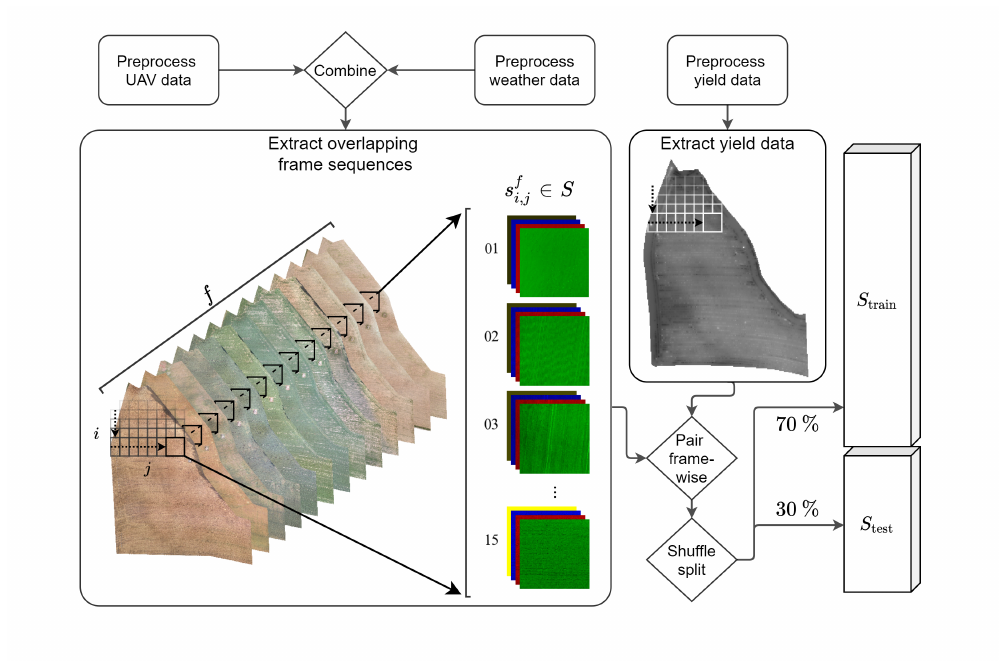
Figure 1. Input frame sequence and target average yield extraction process. Sequences of frames S of fixed width and height were extracted from cumulative temperature enhanced RGB image mosaic sequences as the input data, with f being a distinct field and s f an extracted sequence of frames from i , j f . The four-layer YBRG, Y being the cumulative temperature, input frames were then geolocationally paired with corresponding yield data to form input-target pairs. Lastly, data was shuffled and split to training and test